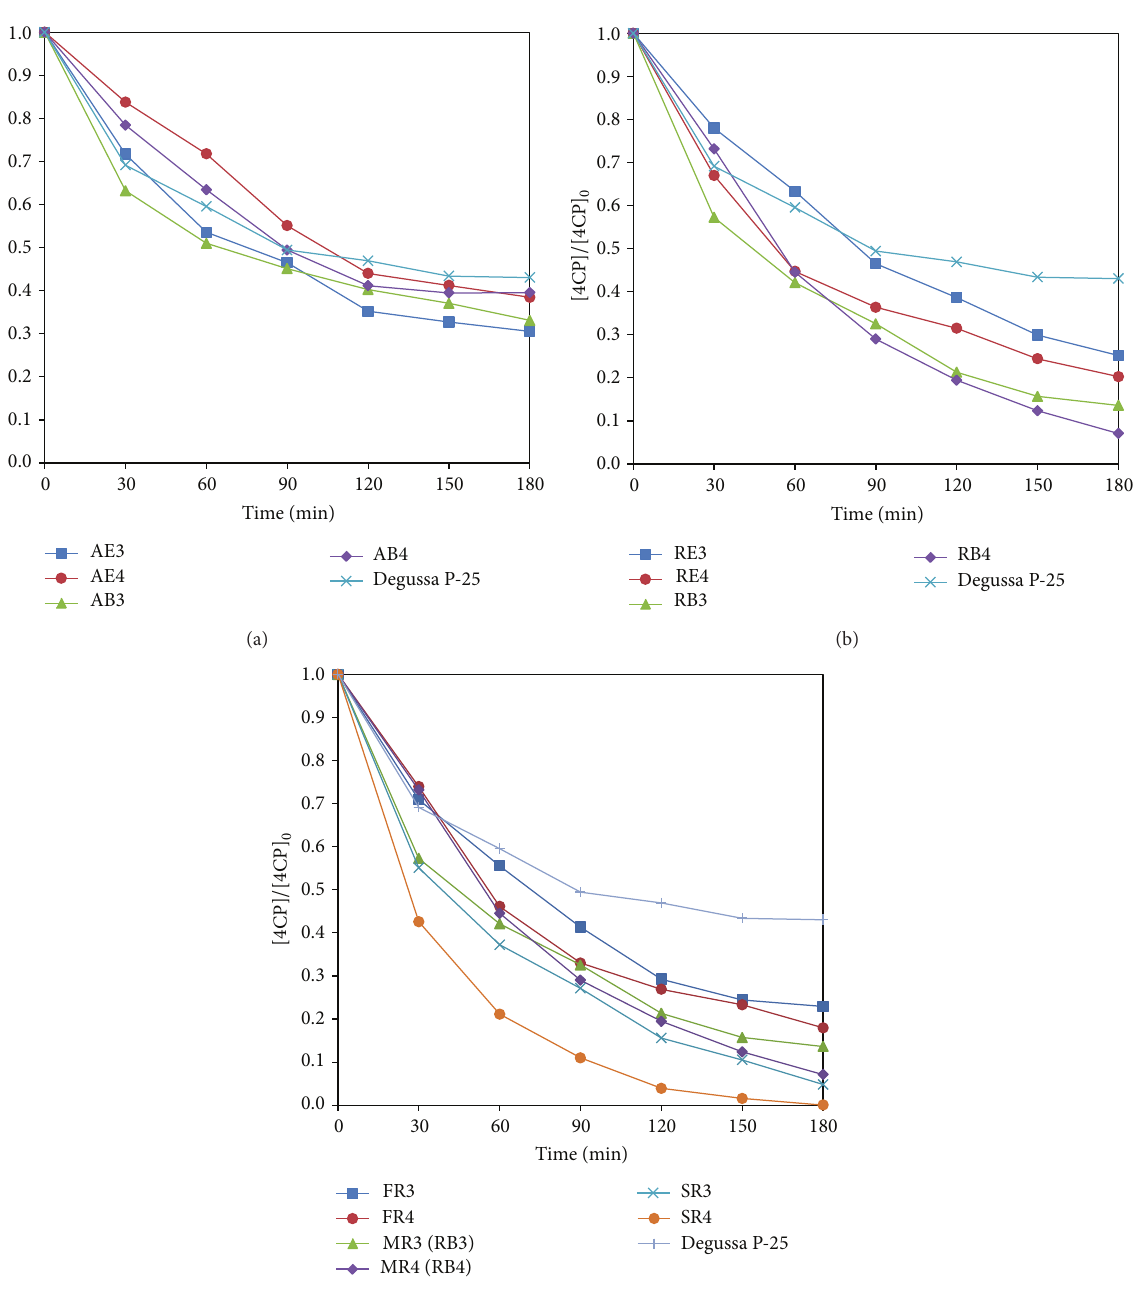
which gives the following, after integration in the interval [𝐶,